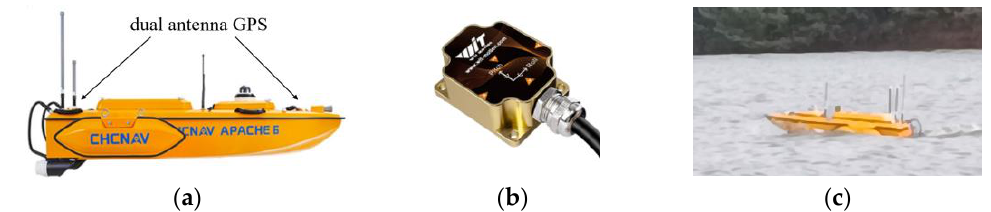
Figure 6. Experimental ship models and sensors: ( a ) experimental model, ( b ) attitude instrument, and ( c ) experimental site.